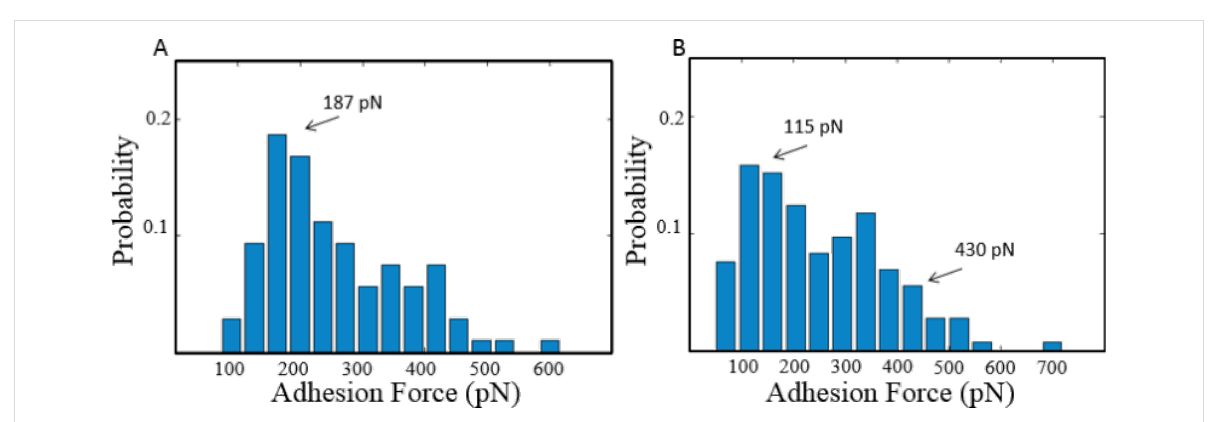
Figure 4: Distribution of bond rupture forces for (A) Si probes (B) Au-coated probes. The most probable force for Si probes was 187 pN, and that for Au-coated probes was 115 pN. In (B), a significant drop of probability was observed for forces larger than 430